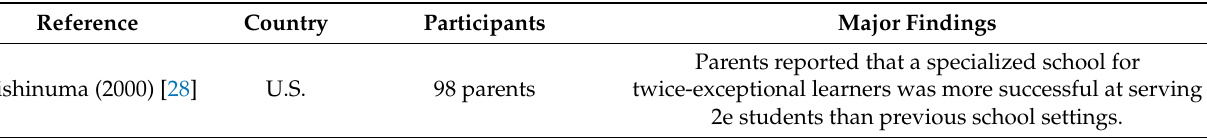
Table 2. Summary of literature on parenting G/T children